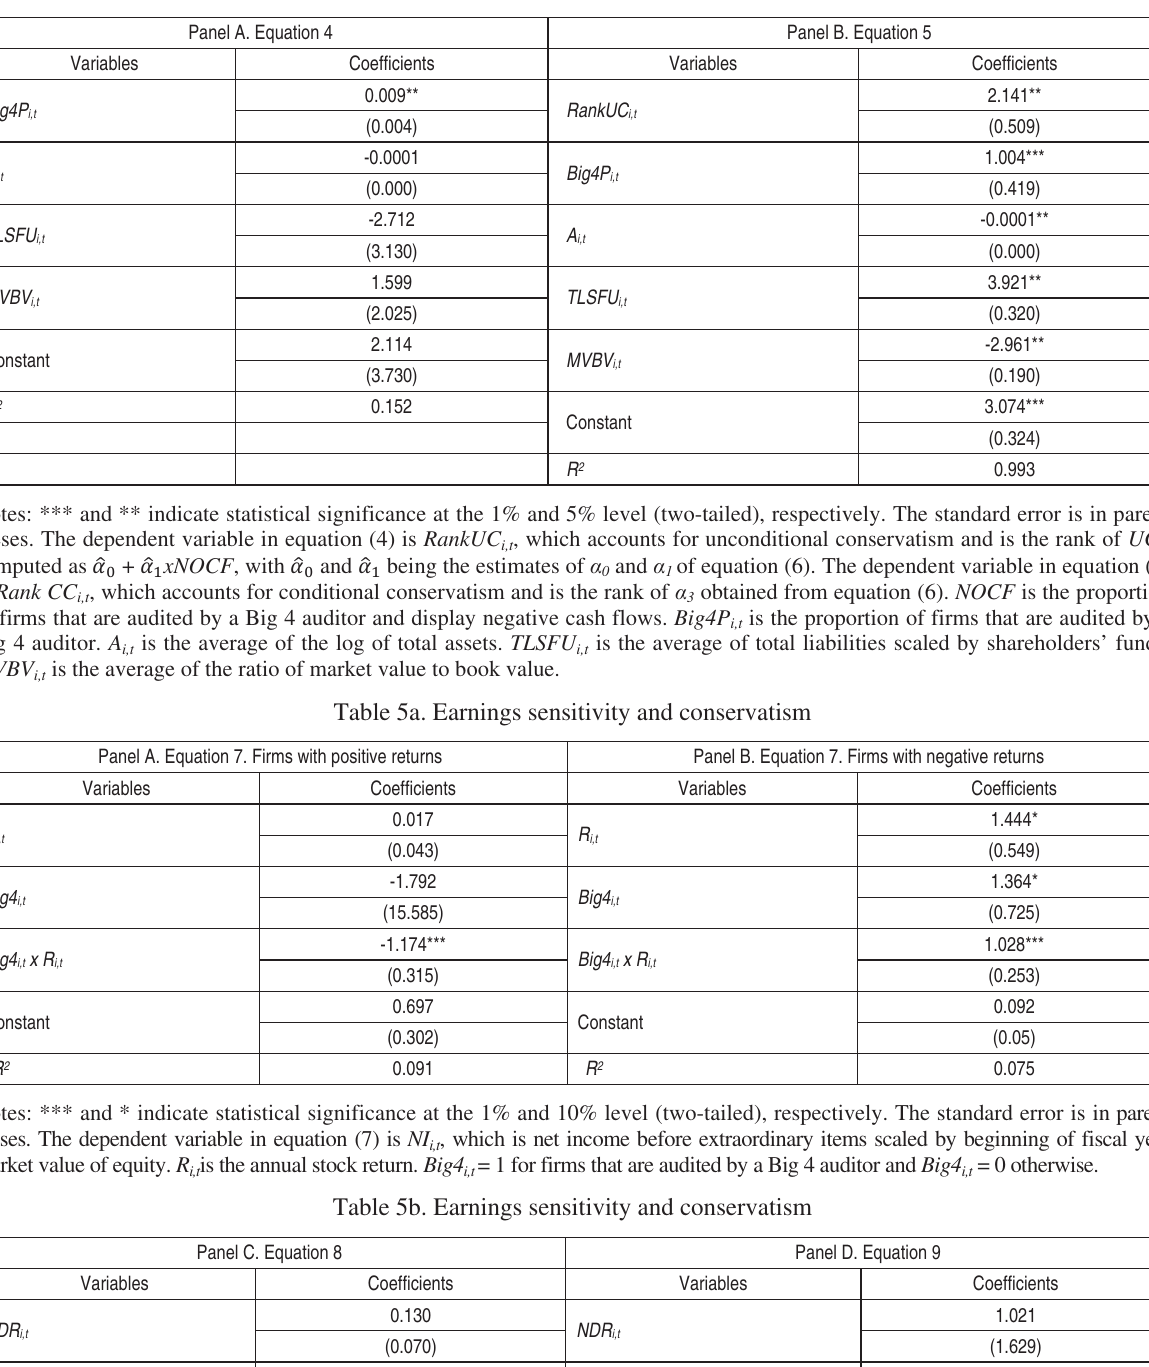
Table 4. Conditional and unconditional conservatism